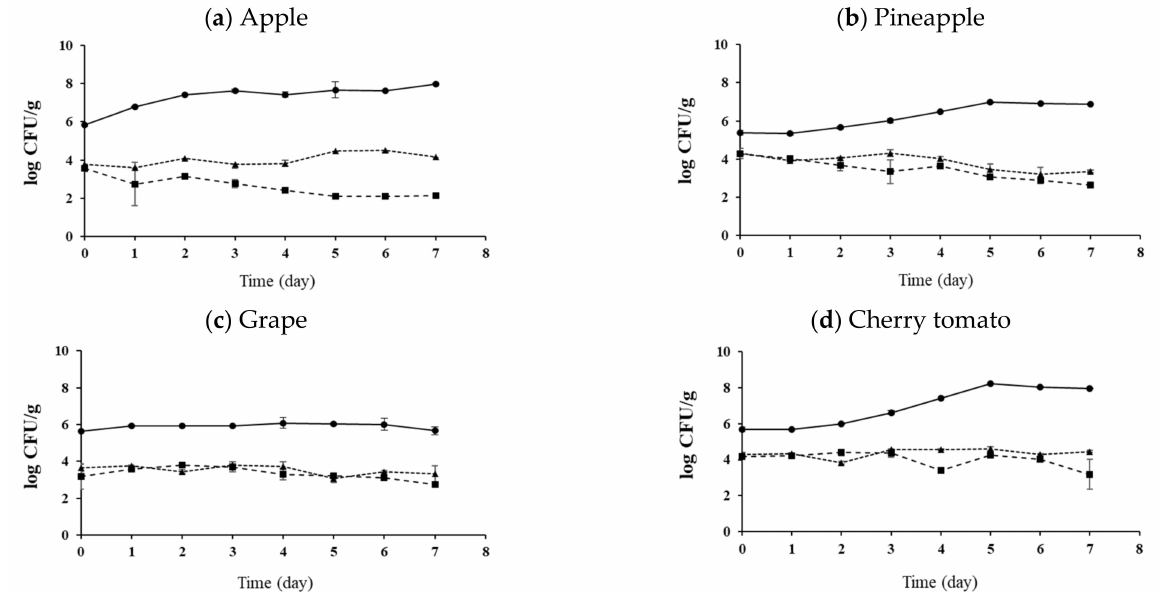
Figure 3. Change of L. monocytogenes population of ( a ) apple, ( b ) pineapple, ( c ) grape and ( d ) cherry tomato with disinfection treatments during storage at 10 ◦ C. Control, no extra wash with a sanitizer; SAEW, slightly acidic electrolyzed water; FA, fumaric acid; UVC W-LED, ultravioletC waterproof light-emitting diodes. Control ( • ), SAEW + FA ( (cid:78) ), SAEW + FA + UVC W-LED ( (cid:4)